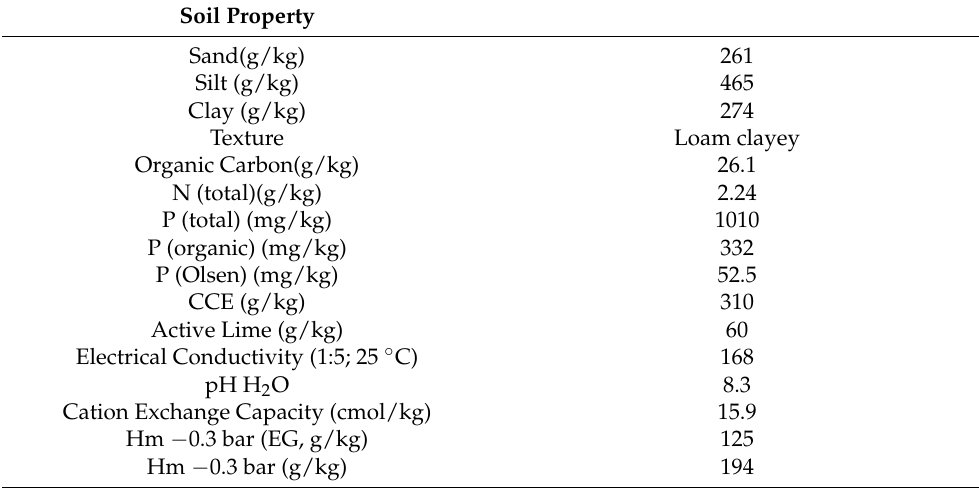
Table 1. Physical and chemical properties of the soil where the assays were carried